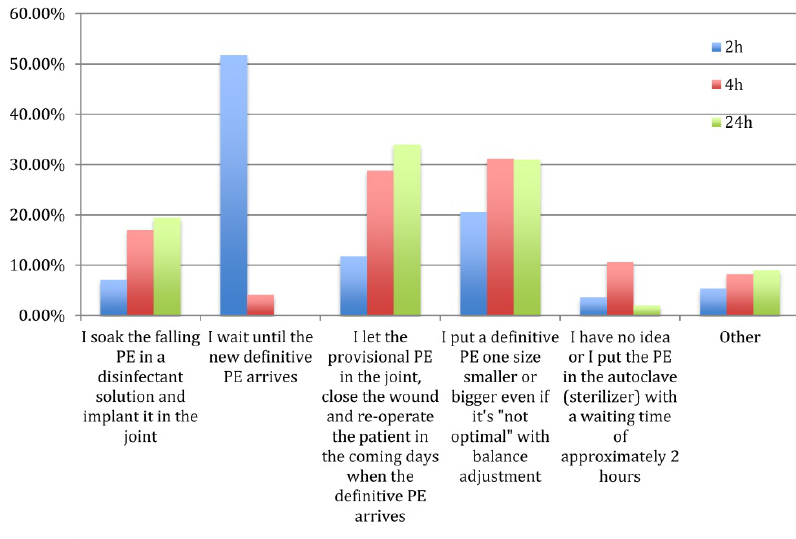
Figure 1. Comparison between three possible situations. ‘During a total knee arthroplasty (TKA) procedure, the definitive polyethylene (PE) falls on the ground. What would you do if a new definitive PE is available only in 2, 4 or 24